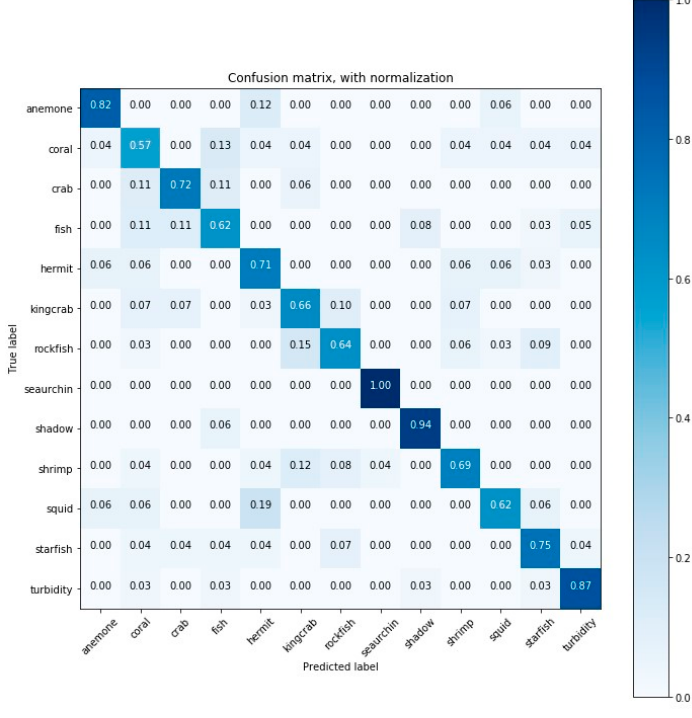
Figure A11. Confusion matrix for the classification results (accuracy) obtained by CNN-4.